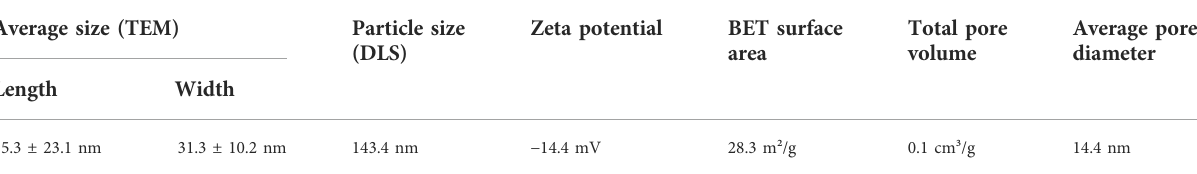
TABLE 2 Characterization of ZnO